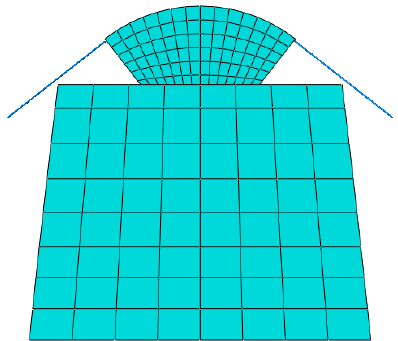
Figure 10. Full bridge finite element model.